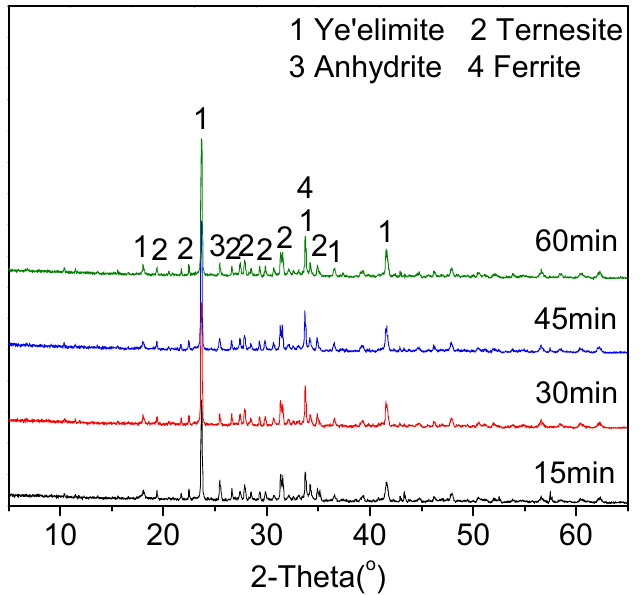
Figure 5. XRD patterns of cement clinker B burned at 1150 °C for different retention times. Table 6. Quantitative mineralogical compositions of clinker B sintered at different temperatures (wt.%).